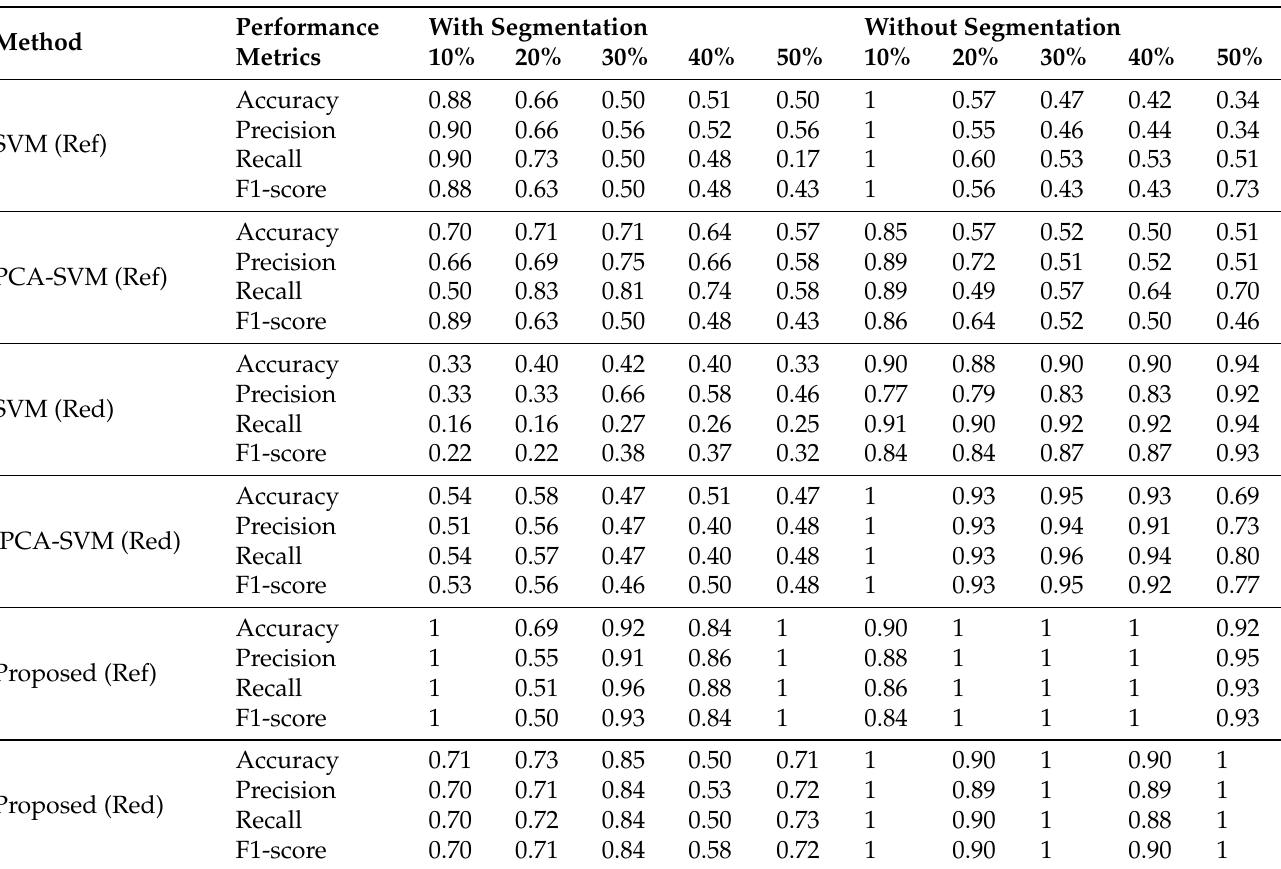
Table 9. Performance metrics for 10%, 20%, 30%, 40% and 50% testing data using Reference frame as * Ref and redundant frame as * Red for with and without